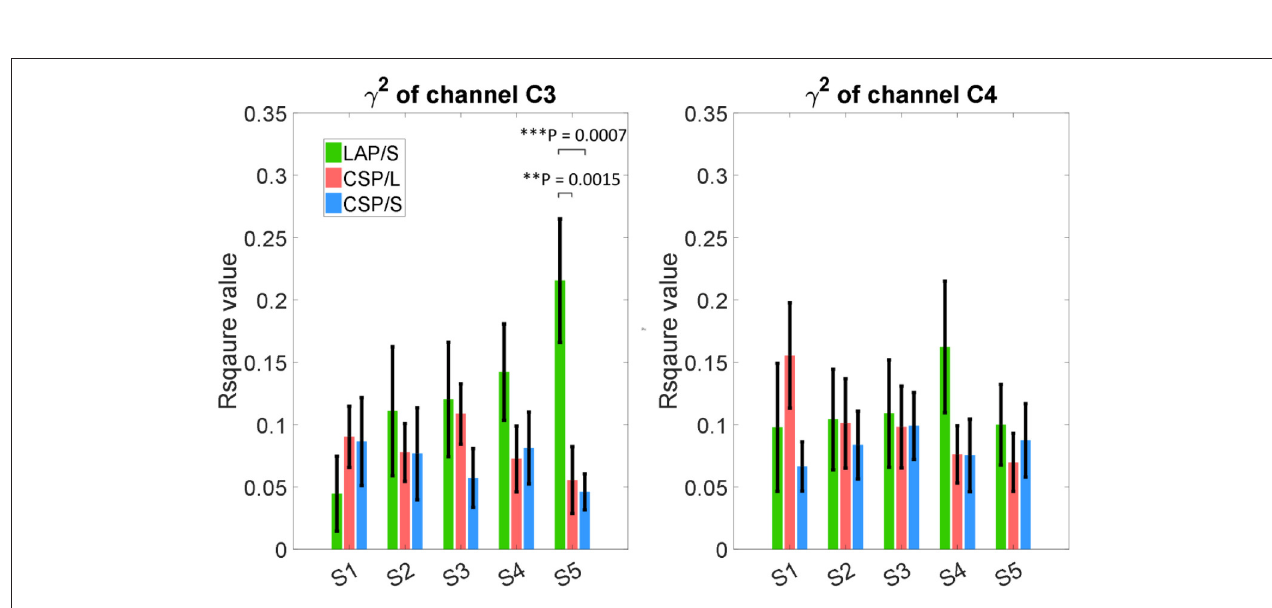
FIGURE 7 | Statistical analysis of group averaged R-squared values, in channels C3 and C4, for the three online decoding methods across five sessions. Group mean ± S.E.M (standard errors of the mean) R-squared values in channels C3 and C4 were shown in the left and right panel, respectively, for the three different methods. Statistically significant different R-squared values were found between method G2:CSP/L- > LAP/S and G1:LAP/S- > CSP/L, between method G2:CSP/L- > LAP/S and G3:CSP/S, in channel C3 at the fifth session.